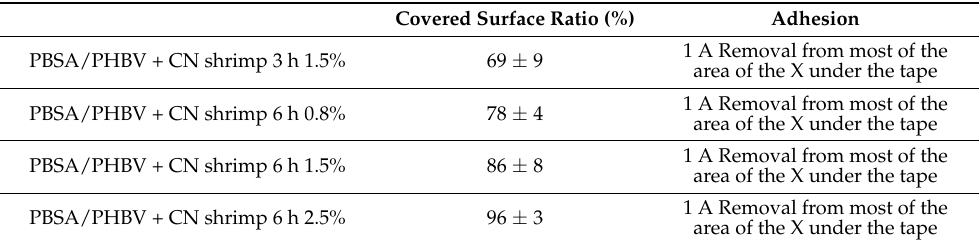
Table 3. Surface analysis of PBSA/PHBV films coated with chitin from shrimps at different time and concentration.